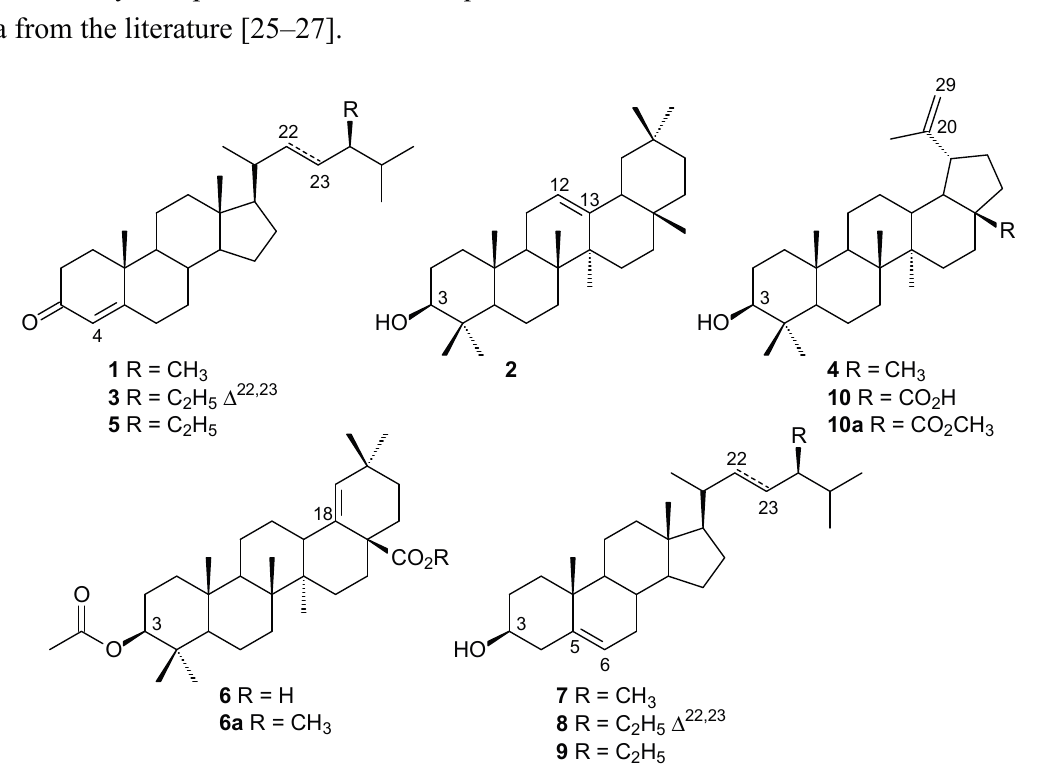
Figure 1. Chemical constituents isolated from the hexane fraction of the ethanolic stem bark extract of Mimosa caesalpiniifolia